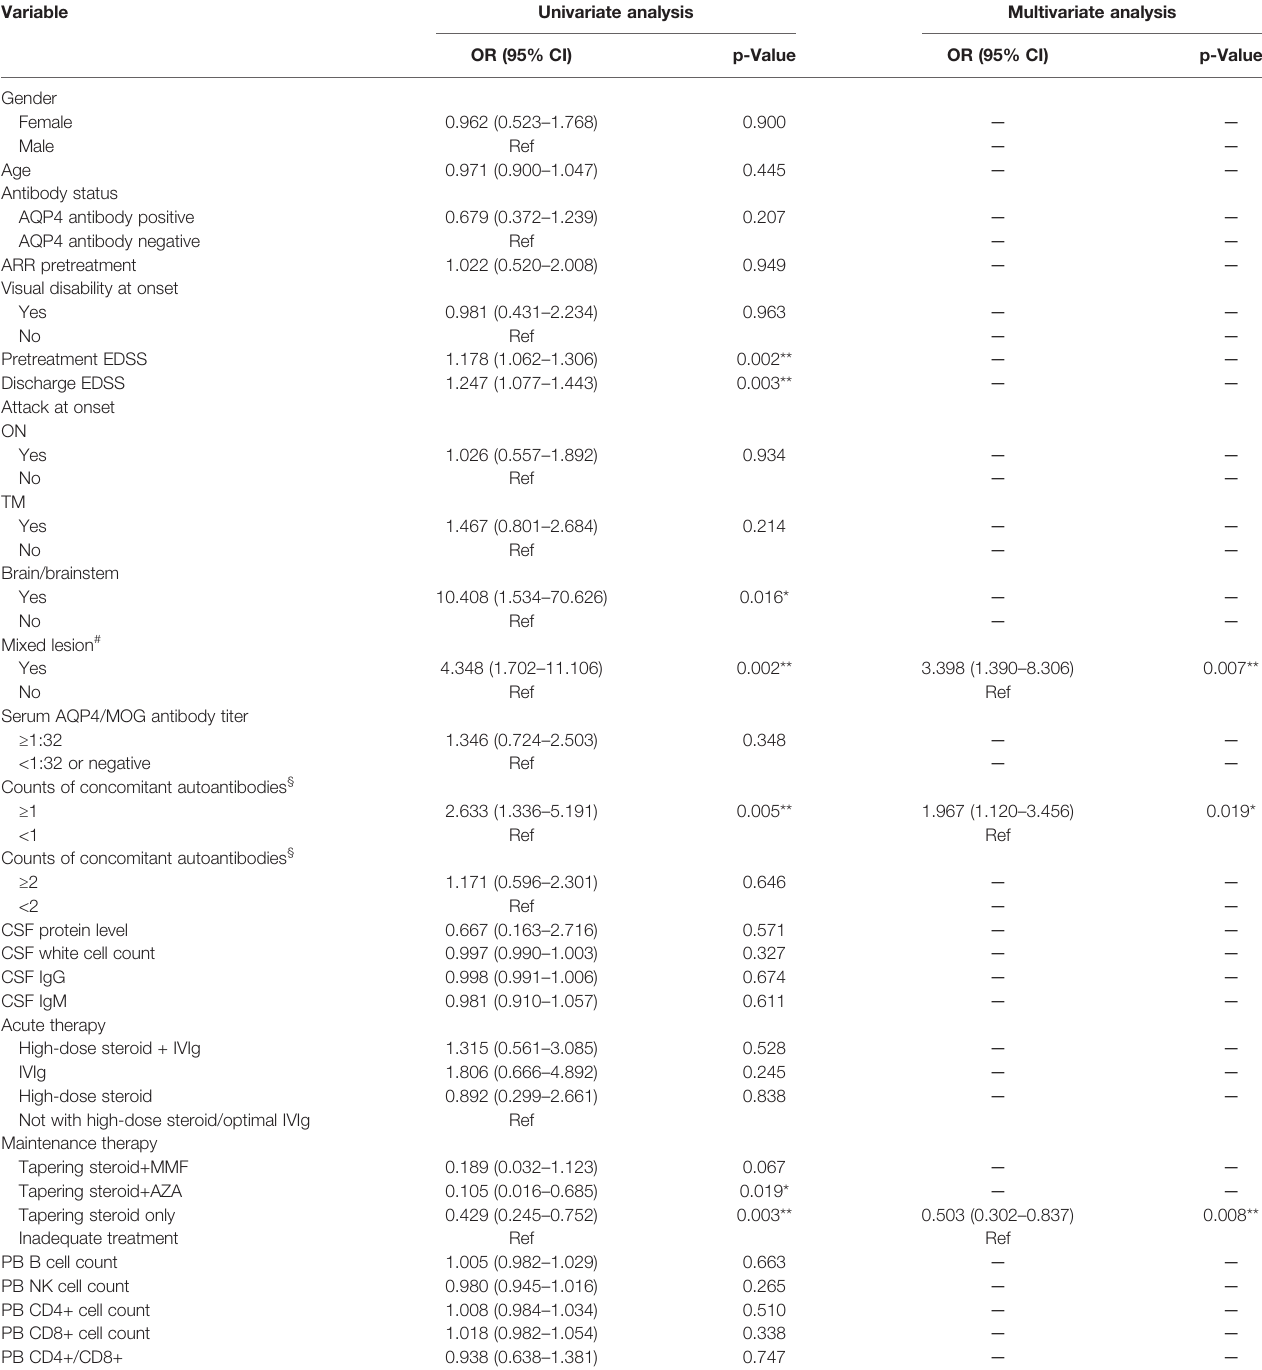
TABLE 4 | Risk factors of relapse attacks using univariate and multivariate Poisson ’ s regression in 1-year